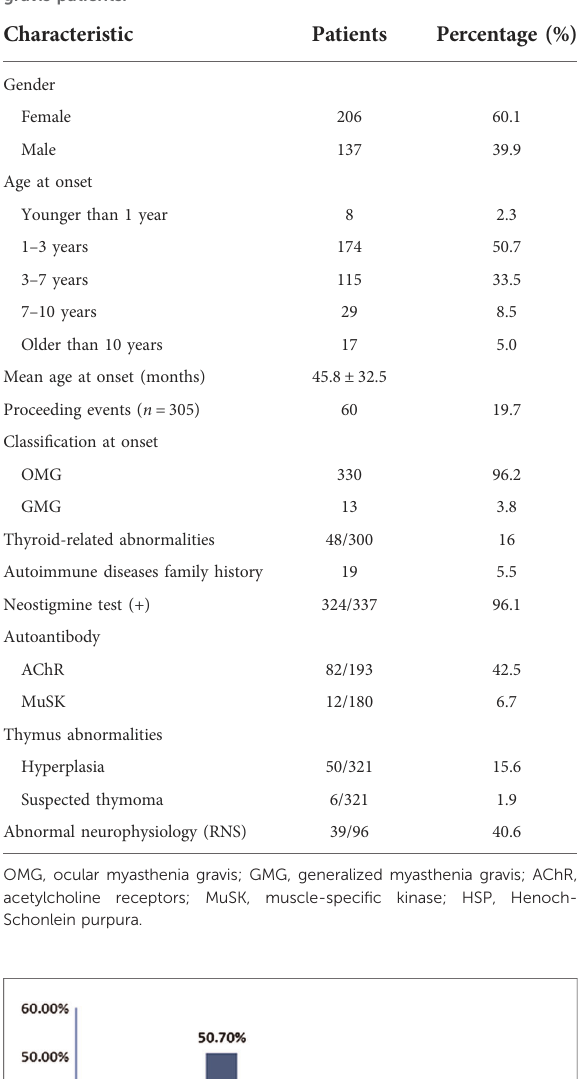
TABLE 1 Clinical characteristics of 343 childhood-onset myasthenia gravis patients.